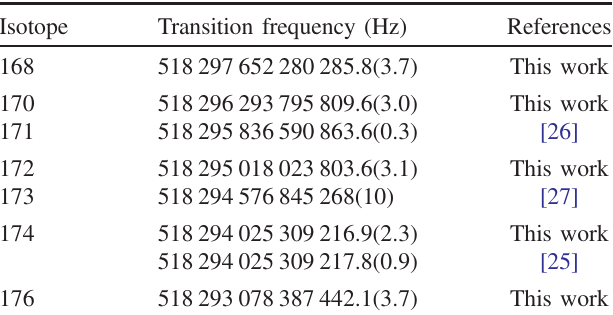
TABLE V. Absolute frequencies of γ ∶ 1 S 0 − 3 P 0 transition.